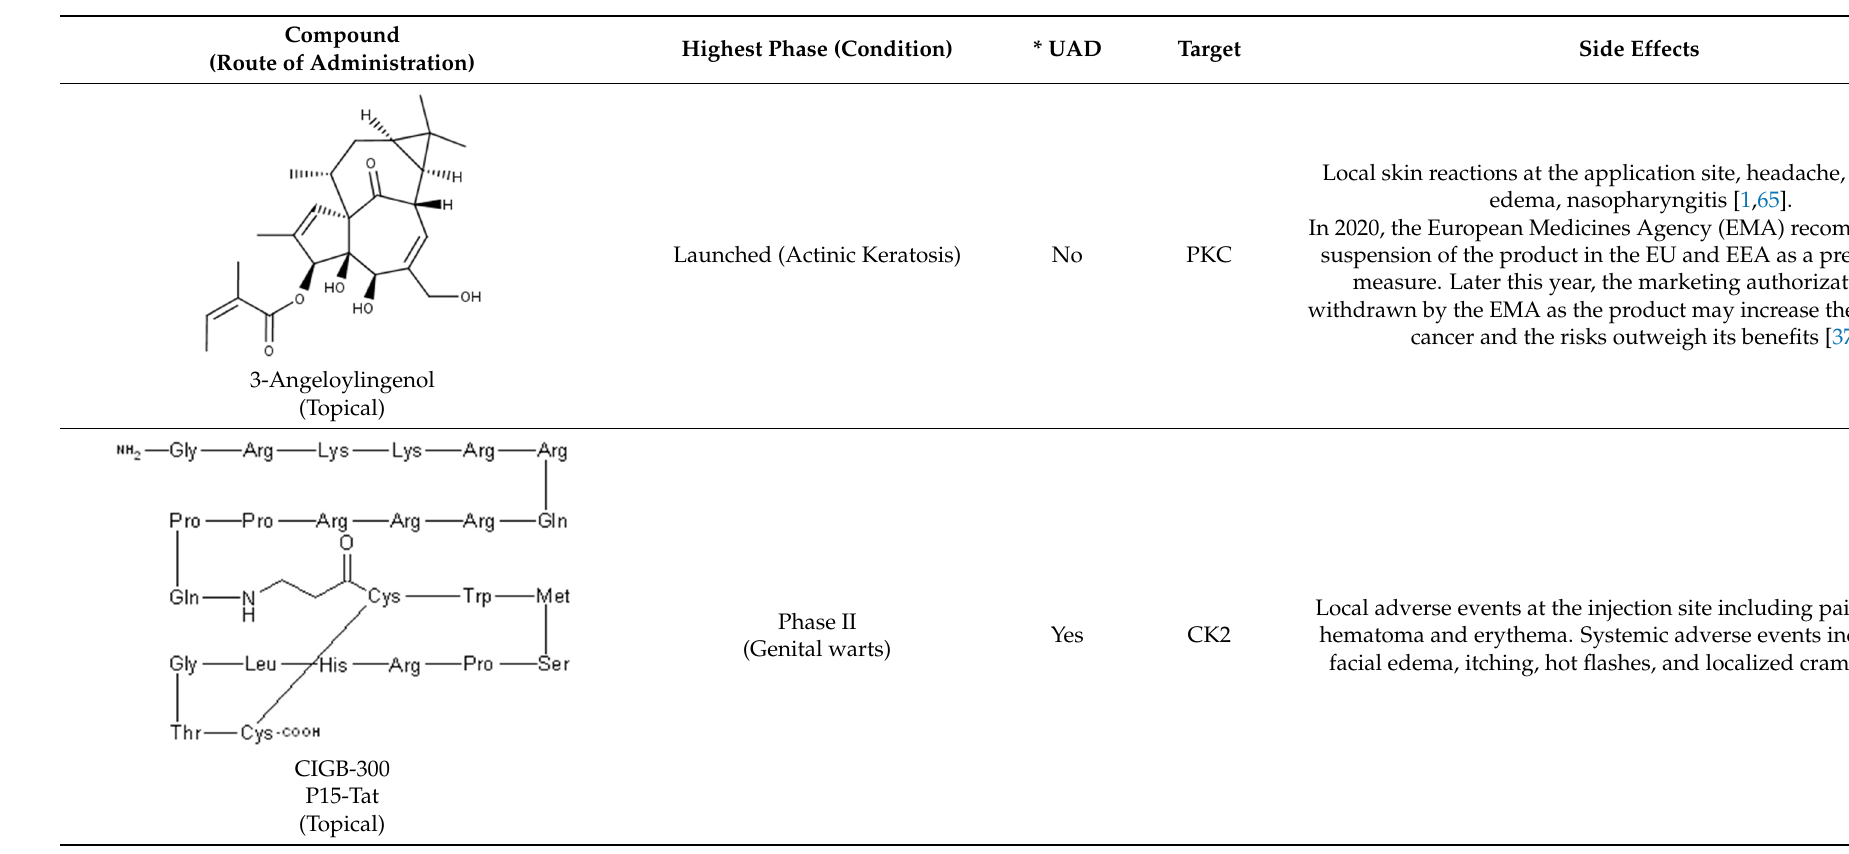
Table 3. Antiviral drugs targeting human kinases in advanced stages of clinical development.